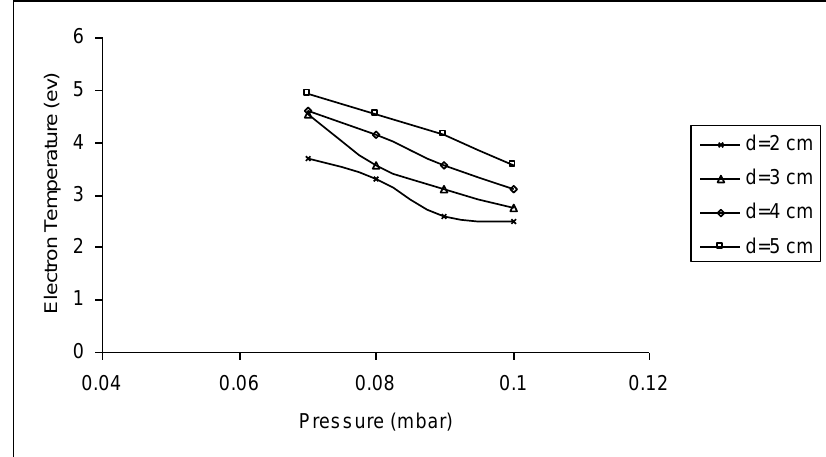
Fig.3: Electron temperatures as a function of plasma pressure for different electrode